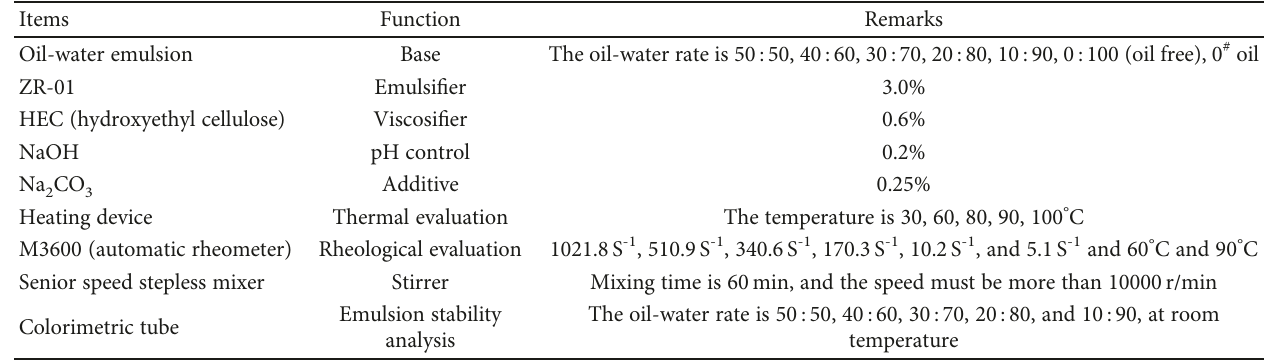
Table 1: The experimental